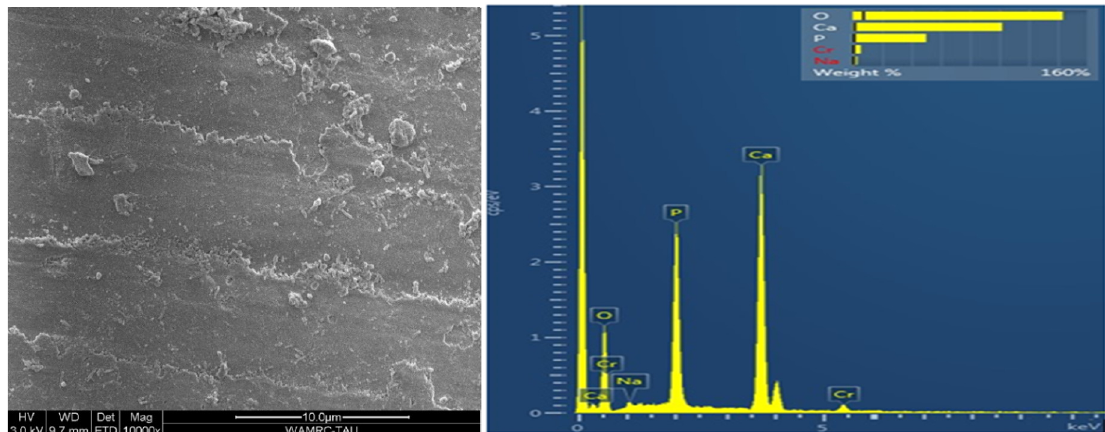
Figure 7. Microscopic image of the untreated control dentin. Surface is covered by smear layer, with smear plugs occluding the dentinal tubules. EDS analysis revealed the following main constituents